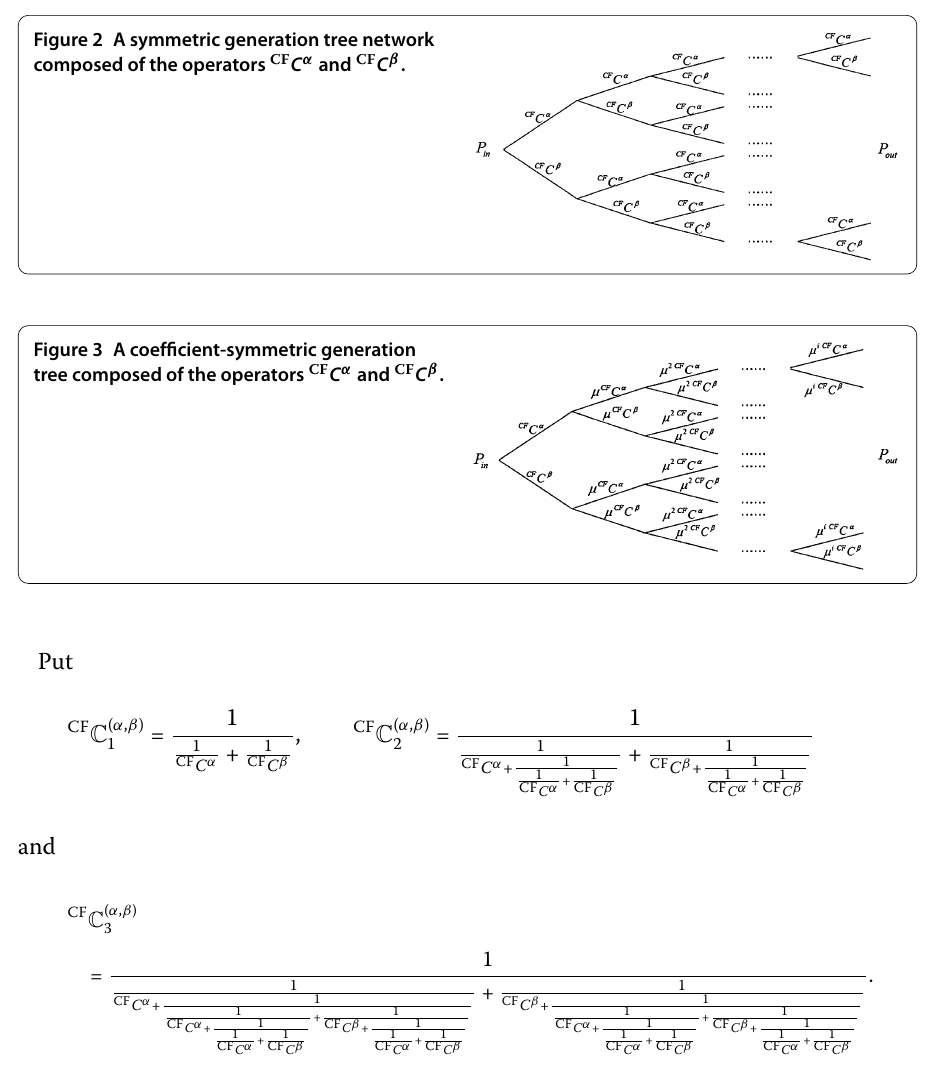
Figure 2 A symmetric generation tree network composed of the operators CF C α and CF C β .